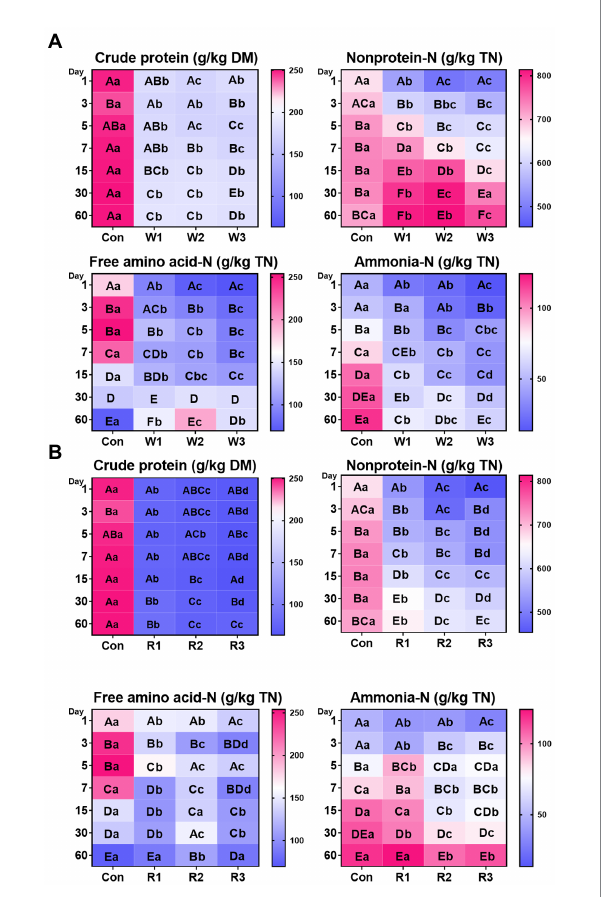
FIGURE 2 Nitrogen distribution (A,B) during the anaerobic fermentation of Chinese cabbage waste. The control group (Con). Chinese cabbage waste was mixed with wheat bran at a mass ratio of 383:117 (W1), 353:147 (W2), and 323:177 (W3) or with rice bran at 387:113 (R1), 358:142 (R2), and 329:171 (R3), respectively; TN, total nitrogen; The significant difference ( p < 0.05) between different days (column) in the same group is represented by the different capital letters; The significant difference ( p < 0.05) between different groups (row) in the same day is represented by the different lowercase